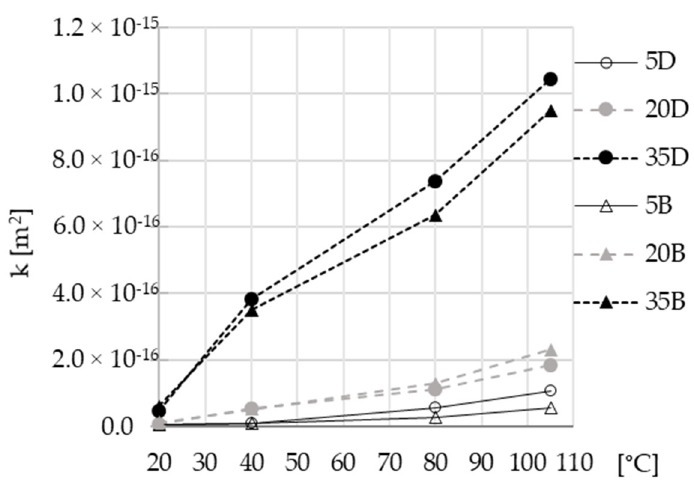
Figure 4. Impact of drying temperature on gas permeability of